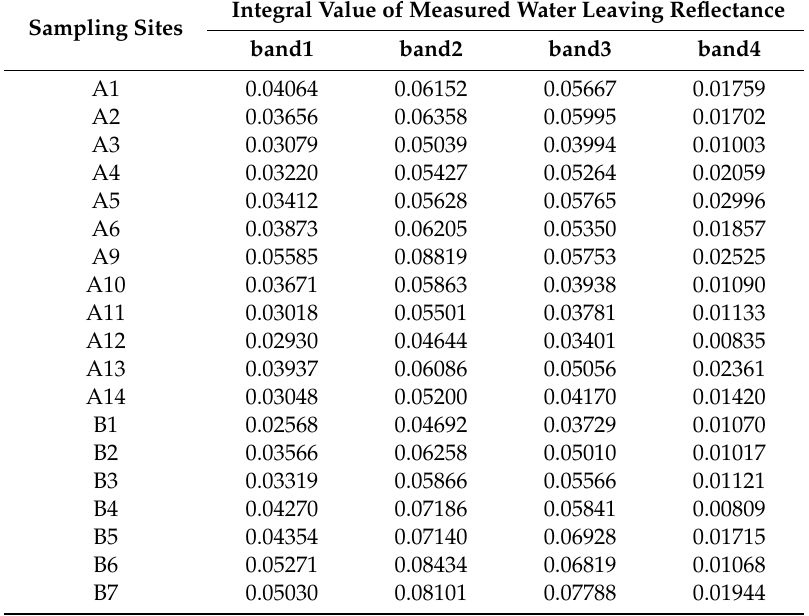
Table A1. The integral value of measured water leaving reflectance of GF-1 multispectral bands. Sampling Sites